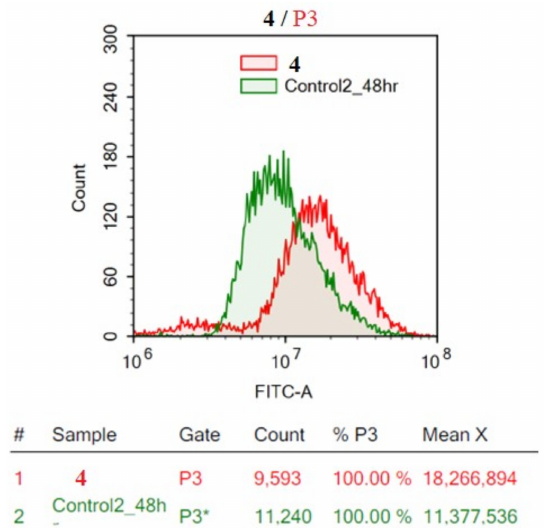
Figure 4. Autophagic cell death assessment in MCF-7 treated with compound 4 (IC 50 = 23.2 µ M) using the acridine orange lysosomal stain coupled with the flow cytometric analysis. The green curve for the negative control (untreated), and the red one for the compound 4 -treated